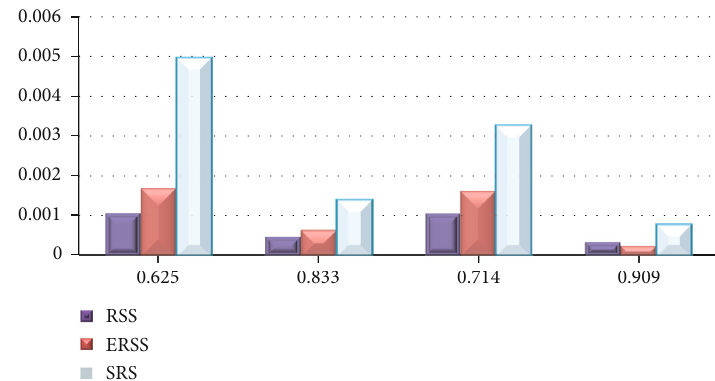
, m = ð 6, 6 Þ . 1 2 Þ